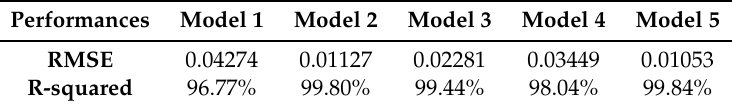
Table 6. Comparison of the OCV models’ precision at 25 ◦ C.